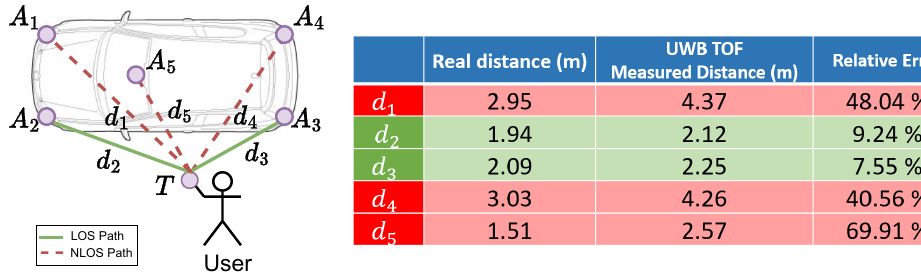
Figure 1. Illustration of the NLOS challenge in the KES. The solid lines d 2 and d 3 denote the LOS paths and the dashed lines d 1 , d 4 , and d 5 denote the NLOS paths. The estimated position of the keyfob can be greatly affected by distances d 1 , d 4 , and d 5 , i.e., more than 40% relative